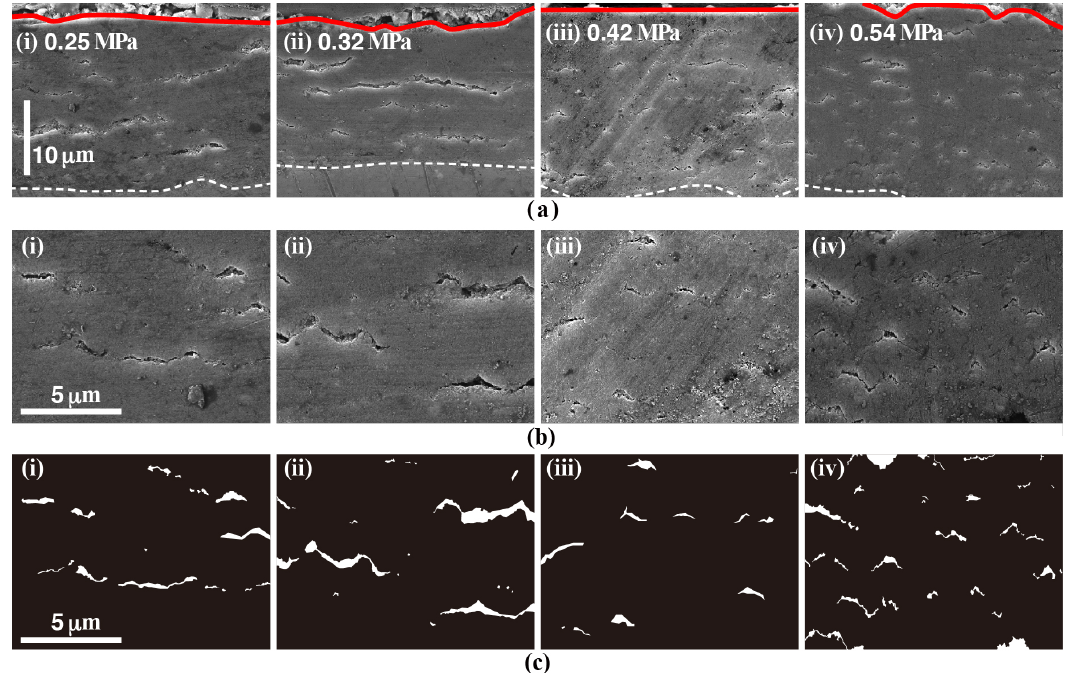
Figure 6. Cross-sectional SEM images ( a ), their enlarged images ( b ), and images with cracks highlighted ( c ) of the film for all samples.